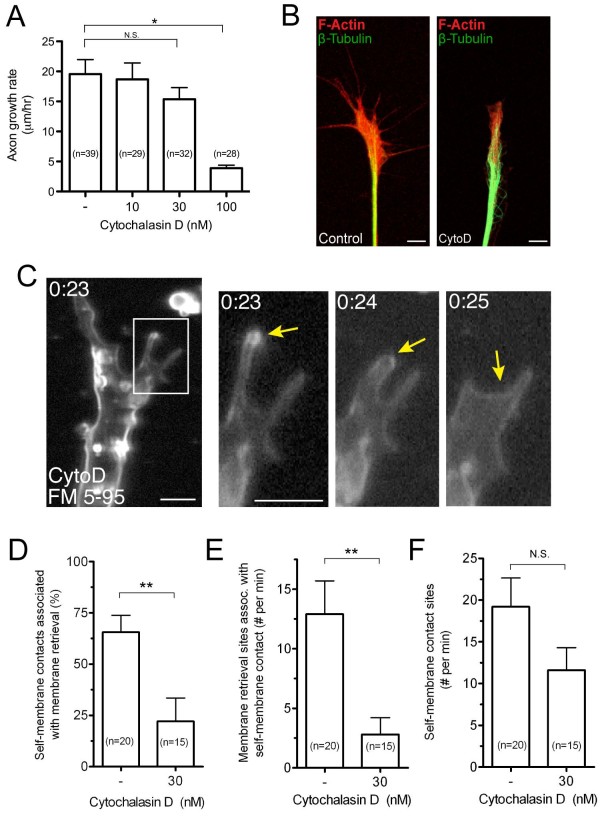
Endocytic vesicle formation at self-membrane contacts requires F-actin. (A) Summary of axon growth rates in vehicle treated controls and after treatment with cytochalasin D during a one-hour growth assay. Data are the mean ± standard error of the mean and the number of axons measured is indicated for each condition. N.S. (no significant difference), P > 0.05, *P < 0.0001, One-way ANOVA, Tukey's post-test. (B) Representative confocal images of control (DMSO) and cytochalasin D (CytoD, 30 nM) treated growth cones show the distribution of F-actin and microtubules, as detected by Alexa555-phalloidin (red) and anti-β-tubulin immunolabeling (green). Note the fewer peripheral processes and reduced F-actin after CytoD. Scale bar, 5 μm. (C) Time-lapse confocal images after a FM 5-95 dye pulse show a motile filopodium (yellow arrows) contacting and fusing with the growth cone peripheral plasma membrane. The self-membrane contact fails to trigger vesicle formation. The boxed region is magnified in the right panels and the time (minutes:seconds) after the initial membrane labeling is indicated in each frame. The corresponding time-lapse movie is shown in Additional file 10. Scale bars, 5 μm. (D-E) Quantitative analysis of membrane retrieval at self-membrane contact sites (filopodial - lamellipodial and filopodial - filopodial contacts) in untreated and cytochalasin D-treated (30 nM) growth cones. The percentage of total self-membrane contact sites associated with membrane retrieval is shown in (D), and the frequency of membrane retrieval events (per minute) occurring at self-membrane contact sites is shown in (E). (F) Frequency (per minute) measurements for the total number of self-membrane contact events, including those not associated with membrane retrieval, measured during the focal membrane labeling assays. For (D-F), data are the mean ± standard error of the mean and the number of growth cones is indicated for each bar. N.S., P > 0.05, **P < 0.01, t-test.